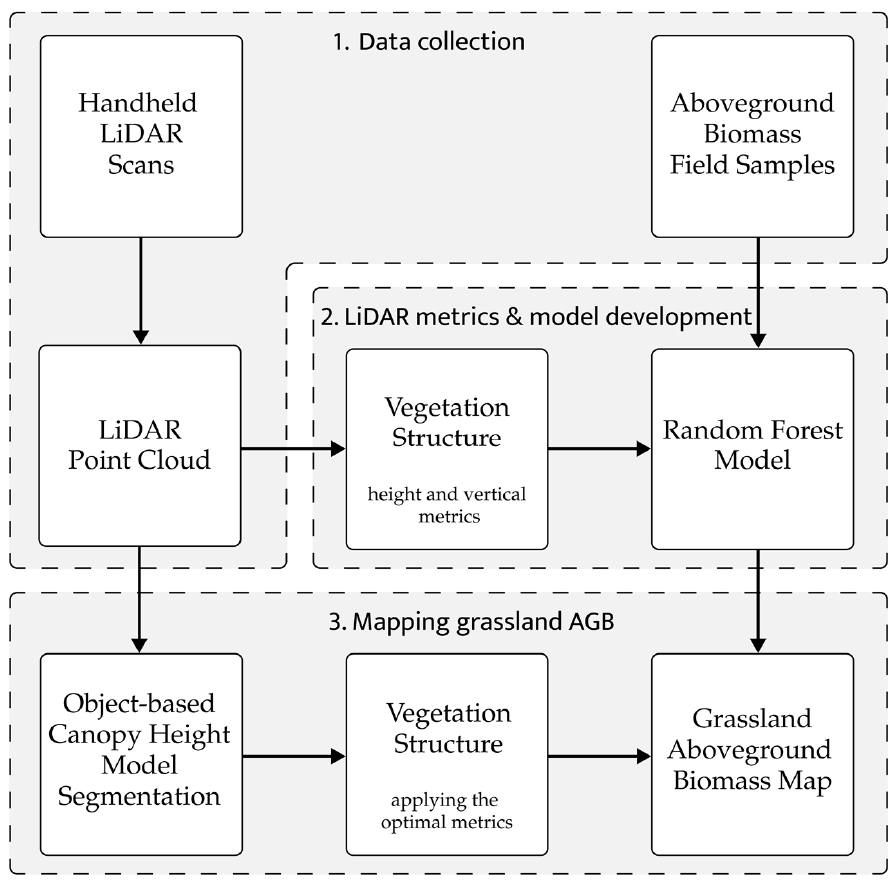
Figure 2. Workflow with three routines for predicting and mapping grassland AGB in the Oostvaardersplassen. 1. Data collection; 2. LiDAR metrics and model development; and 3. mapping grassland AGB.